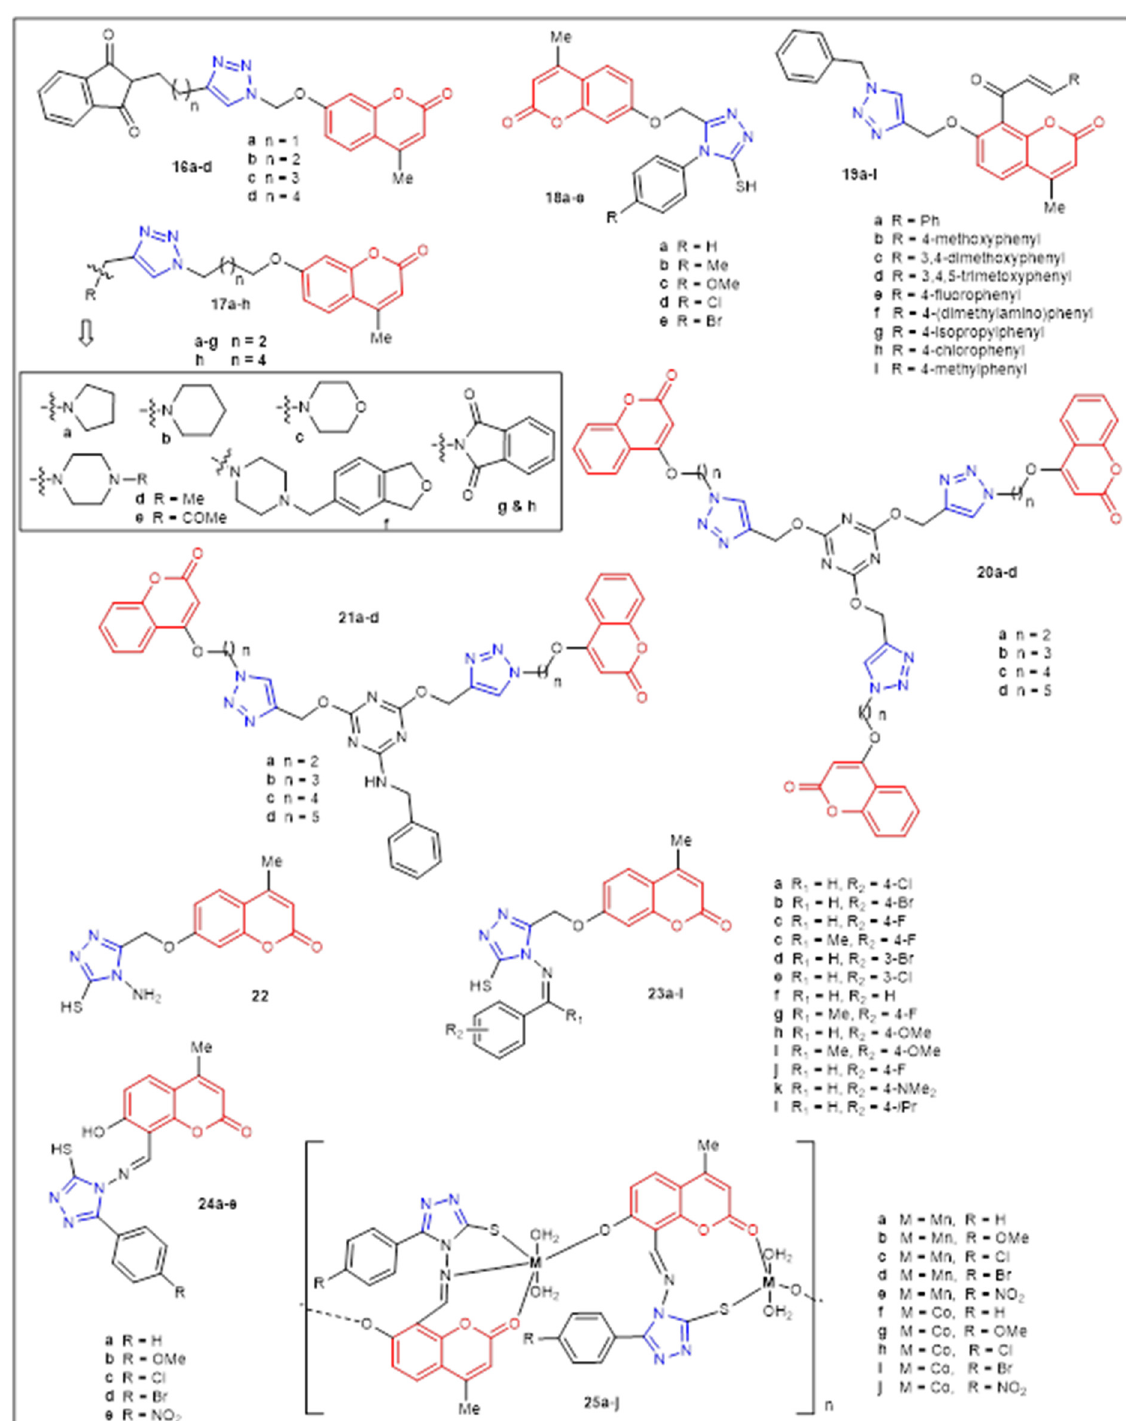
Figure 4. Structures of the reported coumarin triazole derivatives from 2014 – 2015 . In 2015, A. M. Hayallah et al. documented the synthesis and antimicrobial activity of coumarin triazoles 22 and 23a – l (Figure 4) (Table 2) [37]. The in vitro antibacterial activity was determined using S. aureus (AUMC B71) and E. coli (AUMC B69). In general, most of the newly-synthesized compounds exhibited moderate to good antibacterial activities compared to that of ciprofloxacin (20–30 vs. 40 ZoI). Specifically, compounds 22 , 23d , and 23h exhibited the same antibacterial activity against E. coli (MIC = 12.5 µ mol/mL); however, 23d was the most active against S. aureus (MIC = 25 µ mol/mL), but